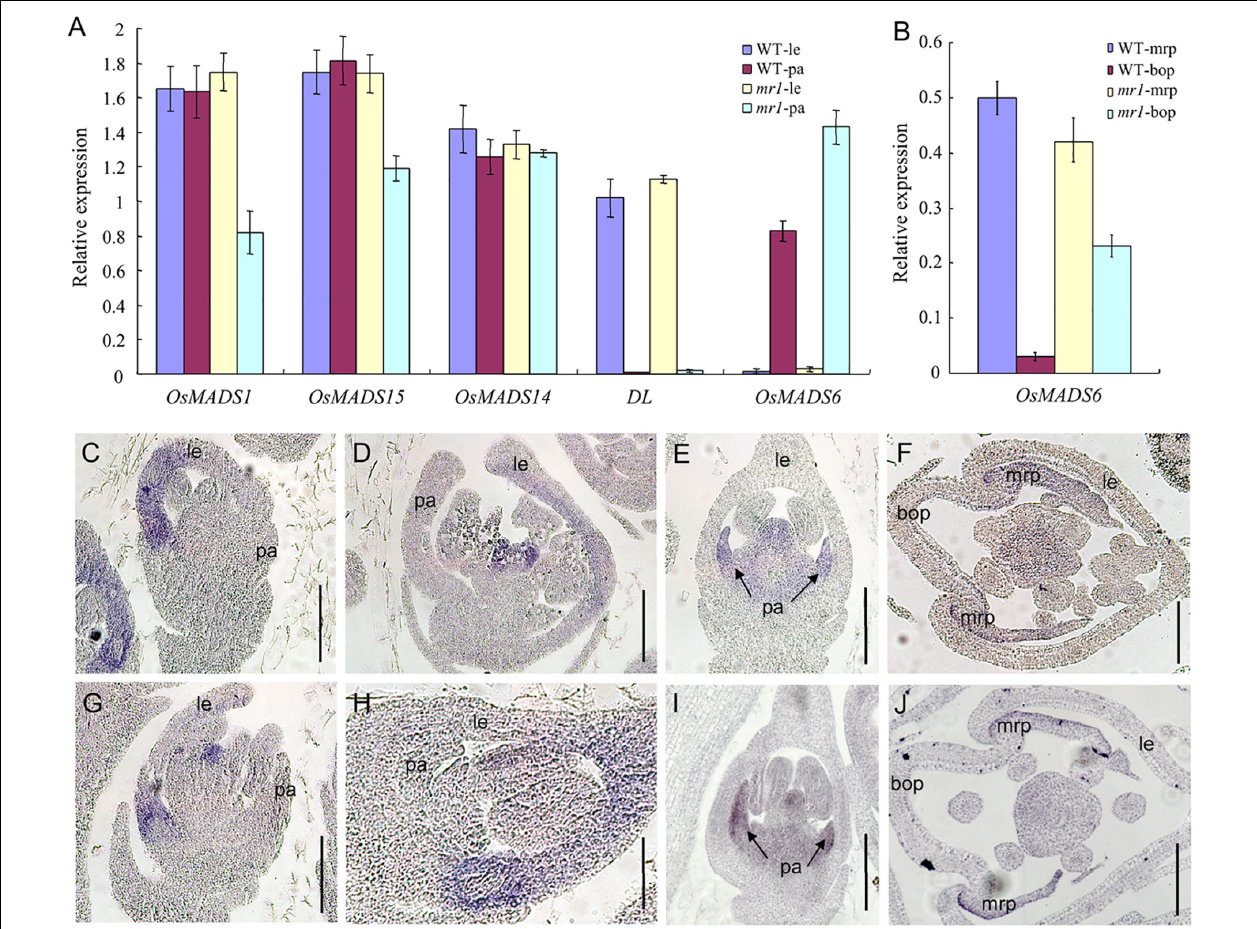
FIGURE 4 | Expression of floral organ genes in the wild-type and the mr1 mutant. (A) Relative expression f genes in the wild-type and the mr1 floral organs. (B) Relative expression f genes in the bop and mrp of wild-type and the mr1 mutant. (C,D) DL expression in the wild-type floret. (E,F) OsMADS6 expression in the wild-type floret. (G,H) DL expression in the mr1 floret. (I,J) OsMADS6 expression in the mr1 floret. le, lemma; pa, palea; mrp, marginal region of palea; bop, body of palea. Bars, 50 µ